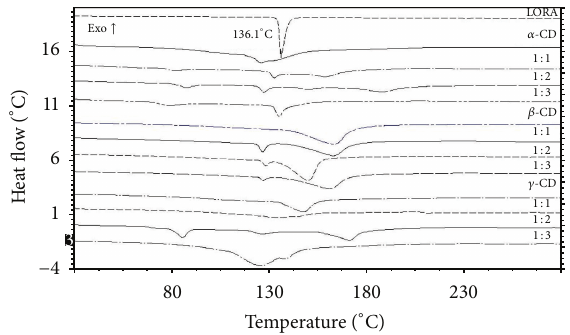
Figure 2: DSC curves of LORA, CDs, and LORA: 𝛼 -CD, LORA: 𝛽 - CD, and LORA: 𝛾 -CD complexes (ratios 1 :1, 1:2, and 1 :3), obtained under a dynamic N 2 (50mL ⋅ min −1 ) atmosphere and a heating rate of 10 ∘ C min −1 .